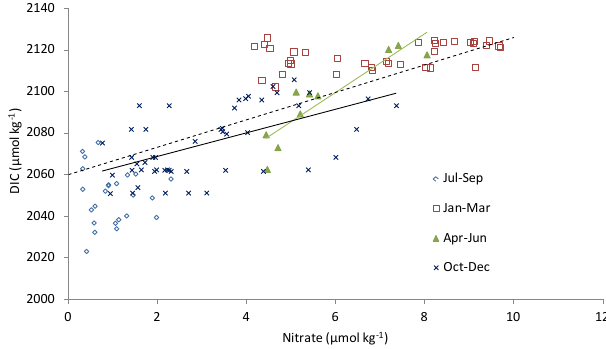
Figure 4. The relationship between concentrations of gas exchange- corrected DIC and nitrate (2010–2012) at the PAP-SO showing 4 different seasons: winter (January–March, red squares); spring (April–June, green triangles); summer (July–September, blue dia- monds); autumn (October–December, dark blue crosses). The green line shows the ratio in spring (14.3) and the blue line is the ratio in autumn (6.4), with the Redfield ratio of 6.6 shown for reference as a dashed line.